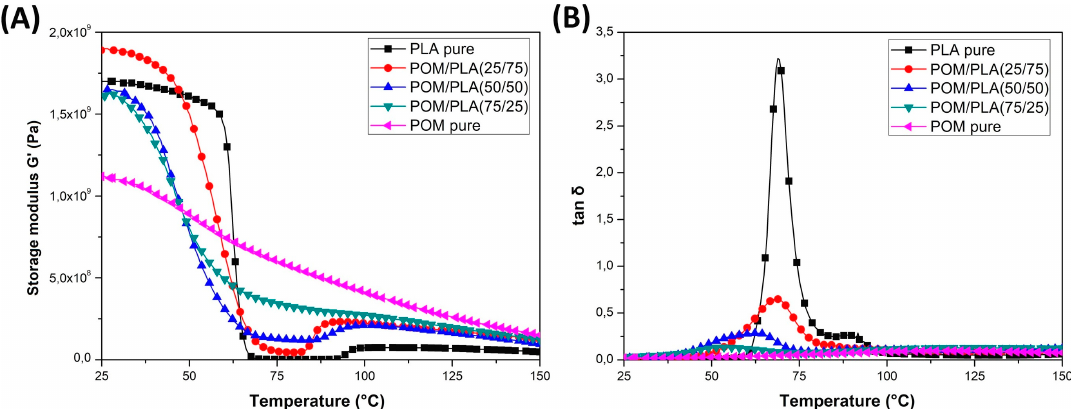
Figure 7. The results of the DMTA measurements for the POM/PLA blends. ( A ) Storage modulus and ( B ) tan thermograms.